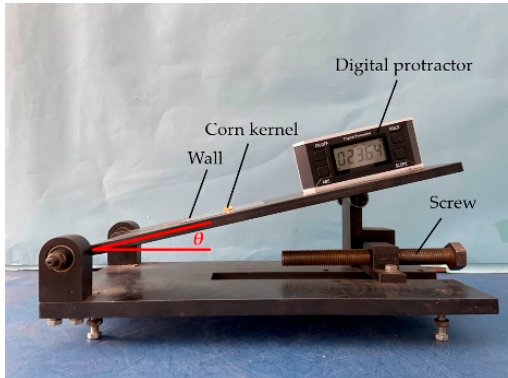
Figure 2. Platform to test the static friction coefficient.